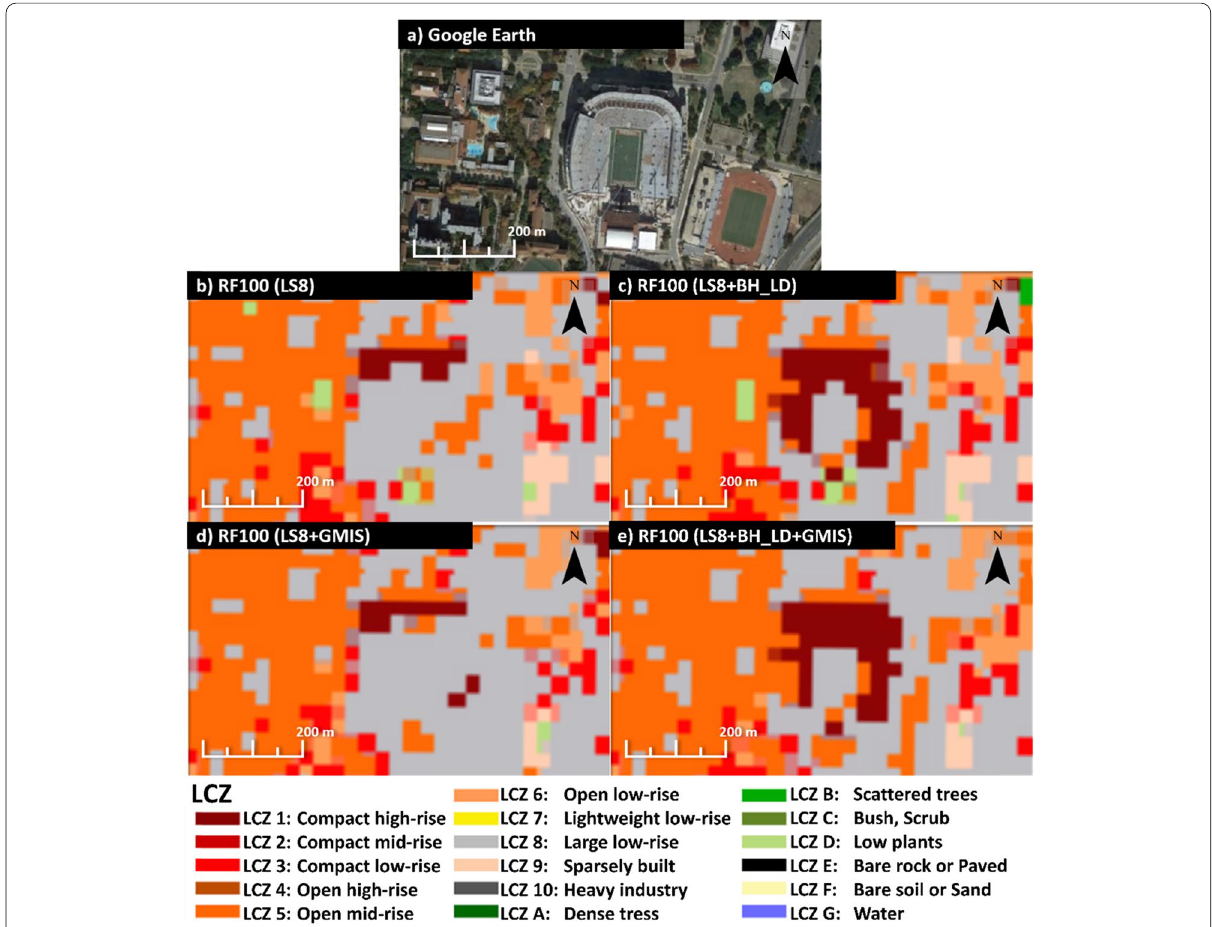
Fig. 8 The a Google Earth image, b RF100 with LS8 as input, c RF100 with LS8 and BH_LD as input, and d RF100 with LS8, BH_LD, and GMIS as input at the Texas Memorial